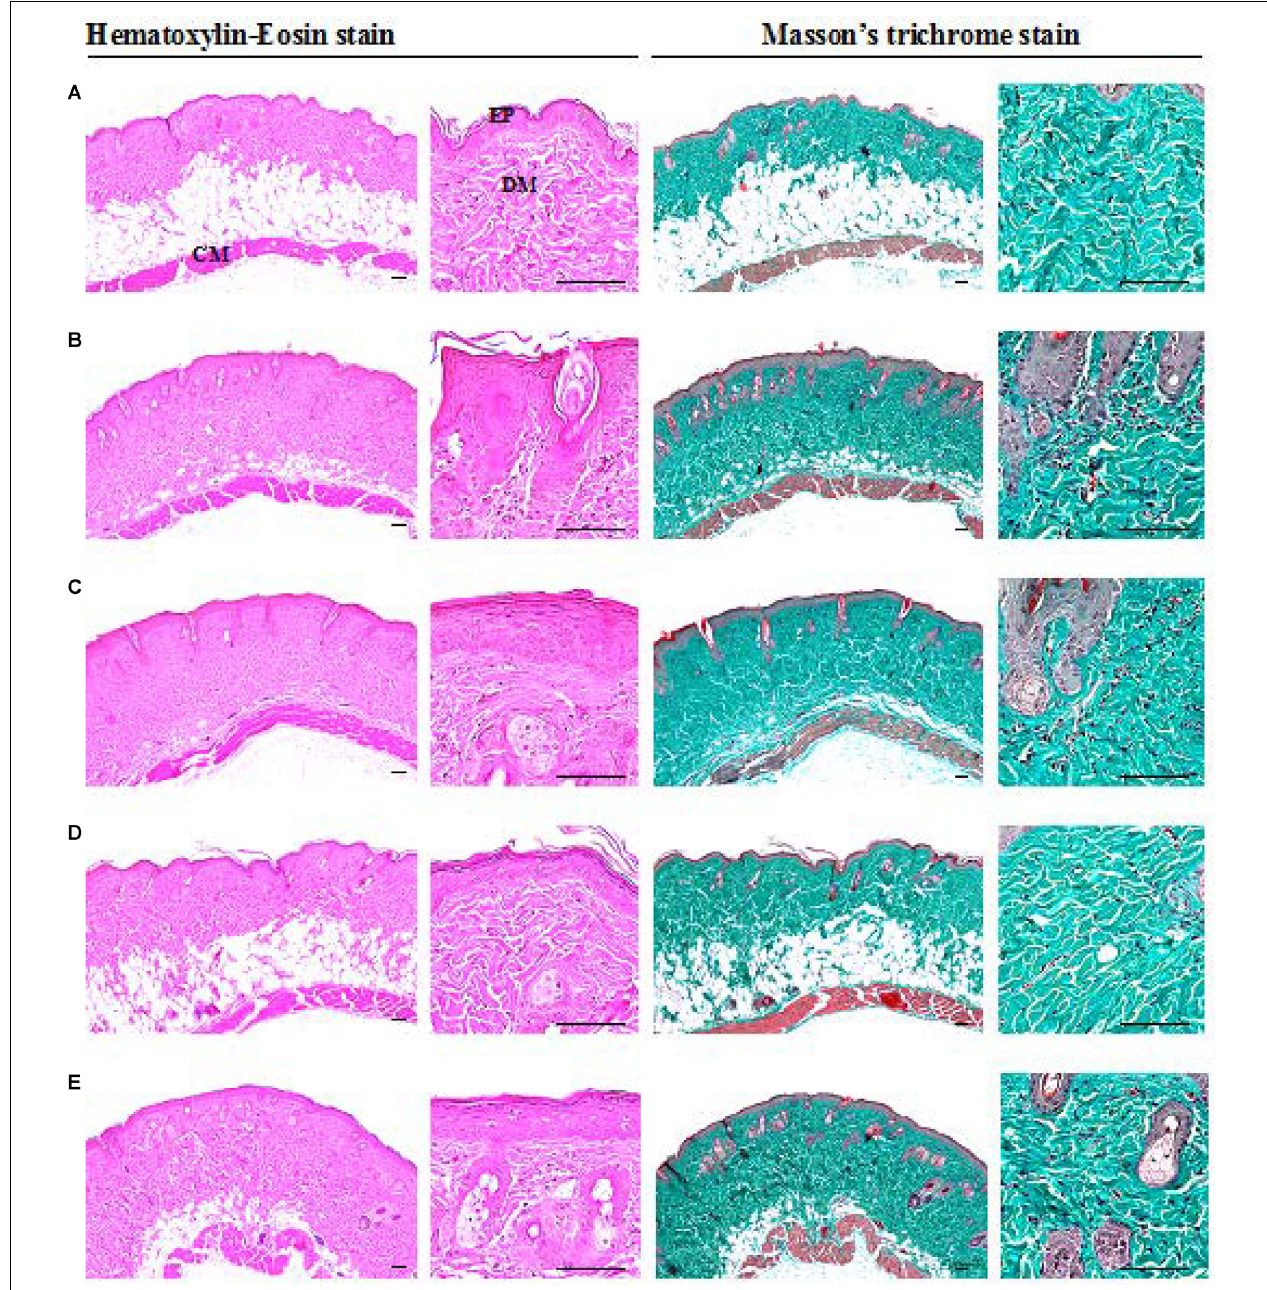
FIGURE 4 | Histopathological images of dorsal skin tissues of IMQ-induced psoriasis mice. (A) Control, (B) IMQ, (C) IMQ+vaseline, (D) IMQ+clobetasol, and (E) IMQ+SEL001. Increase of dorsal skin epithelial thickness and inflammatory cell infiltrations in dermis of dorsal skin were noticed in IMQ control and IMQ+vaseline as compared with intact control, respectively. But no significant changes on the dorsal back skin total thicknesses and collagen fiber occupied regions in the dermis were demonstrated in IMQ control and IMQ+vaseline as compared with intact control and no significant histopathological changes in the dorsal skin tissues were demonstrated in IMQ+vaseline as compared with those of IMQ control. These IMQ-induced hypersensitive psoriasis related histopathological changes on the dorsal skin tissues were significantly inhibited by treatment of SEL001 and